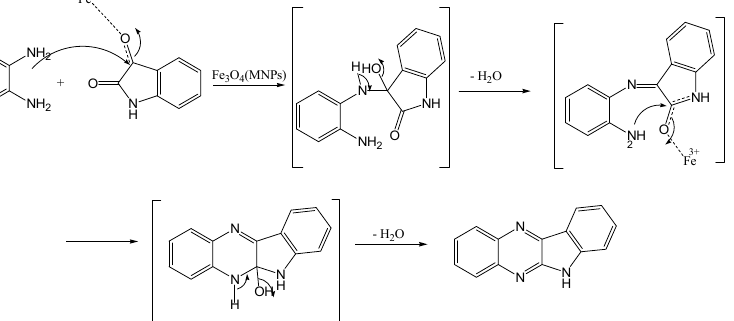
Scheme1: Plausible mechanism for the synthesis of 6H-Indolo[2,3-b]quinoxaline